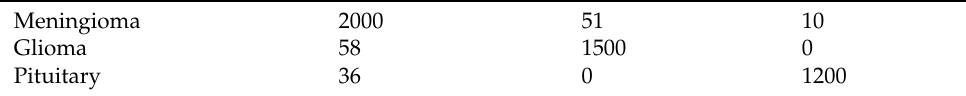
Table 3. Confusion matrix of three classes’ tumors with Augmentation.